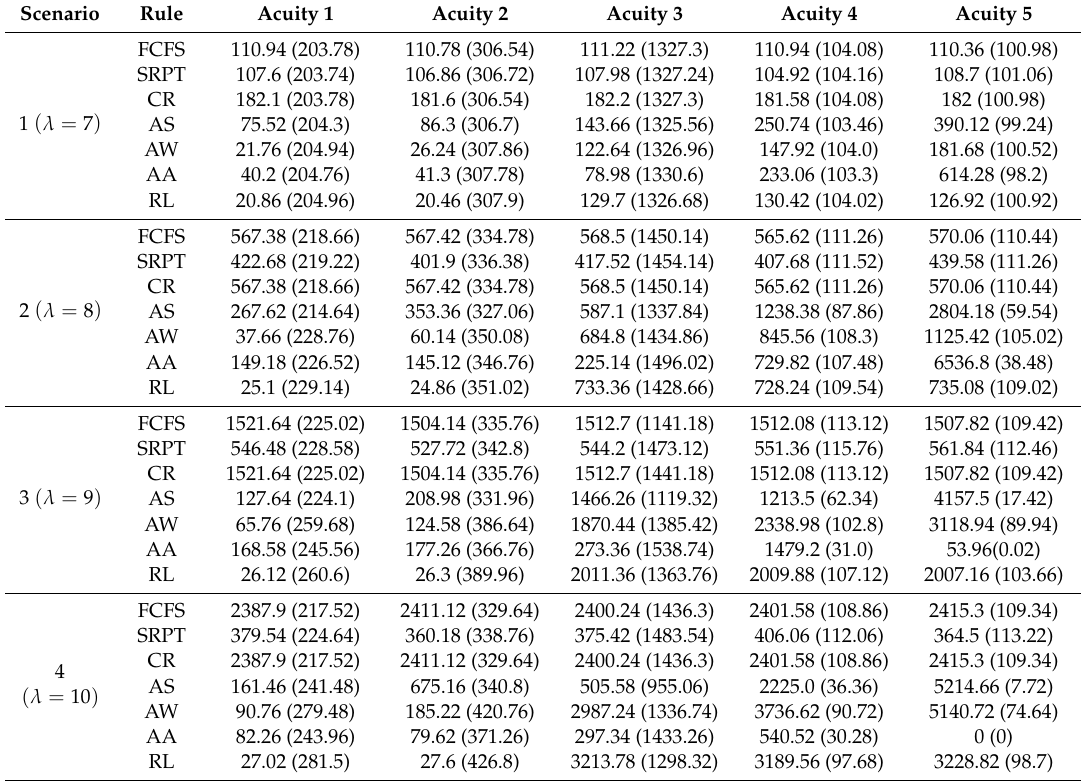
Table A1. Waiting time and number of discharged patients (min /